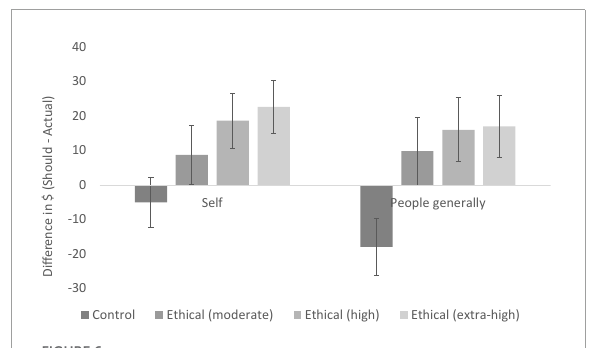
FIGURE6 Should–actual differences for jeans (Experiment 3); error bars show 95% confidence